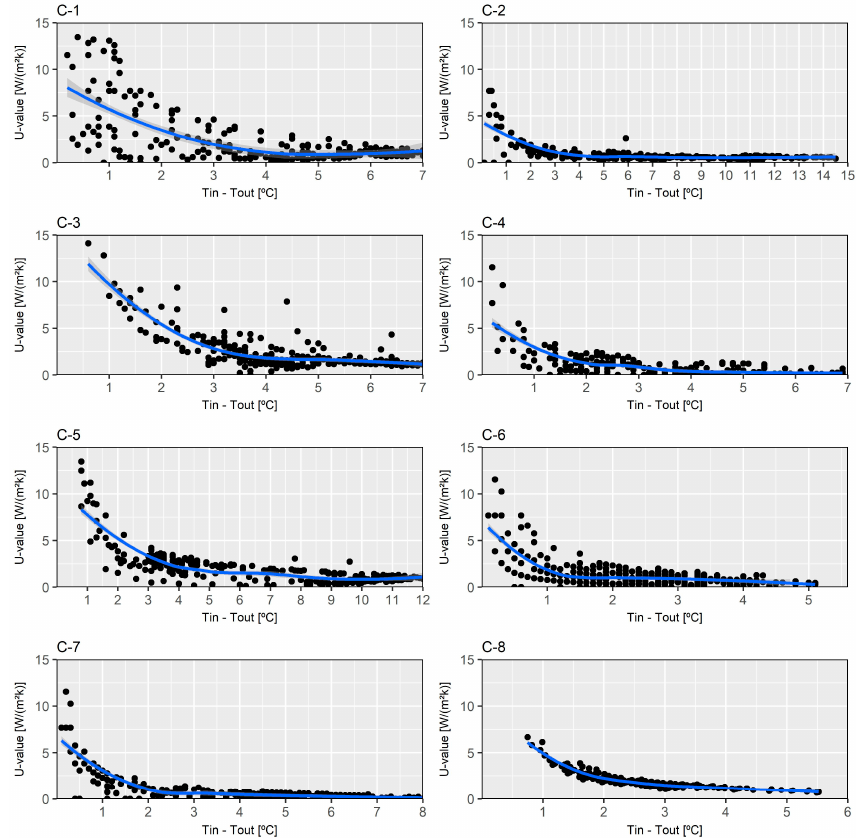
Figure 6. Dispersion of U -value data according to the differences between the external and internal environmental temperatures. The local regression (LOESS) curve is represented by the blue line.